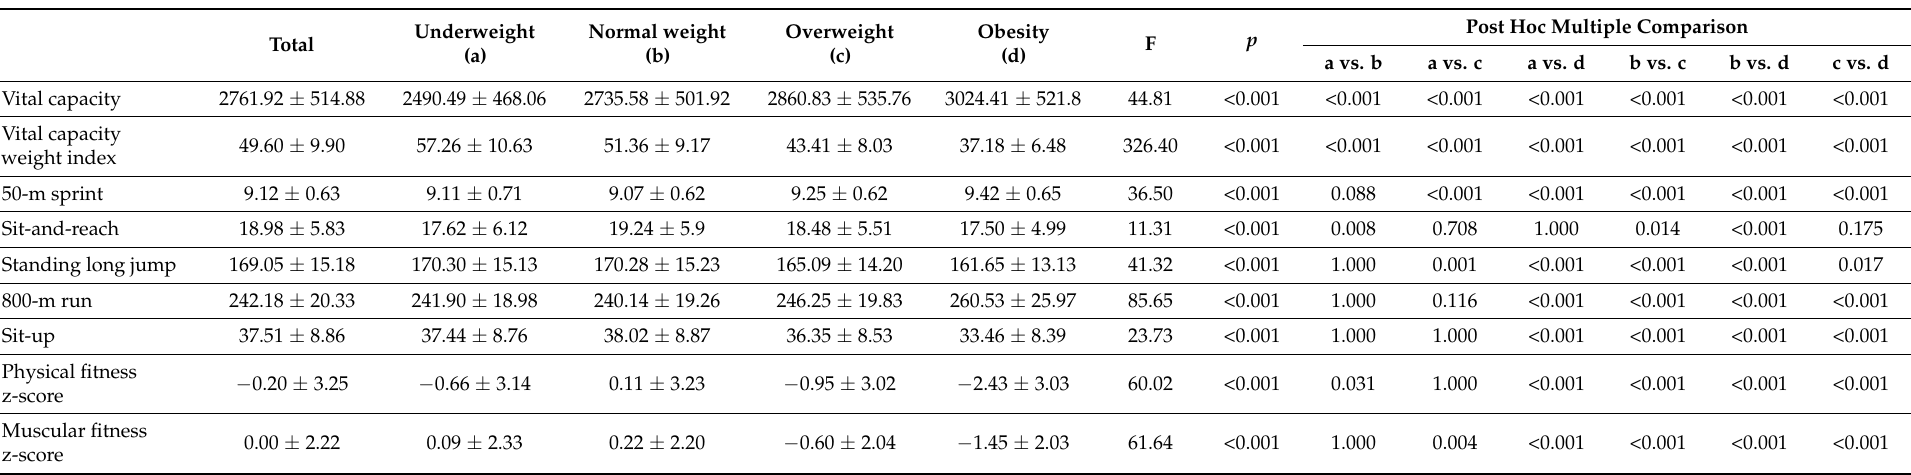
Table 3. Difference of physical fitness stratified by BMI category in female college